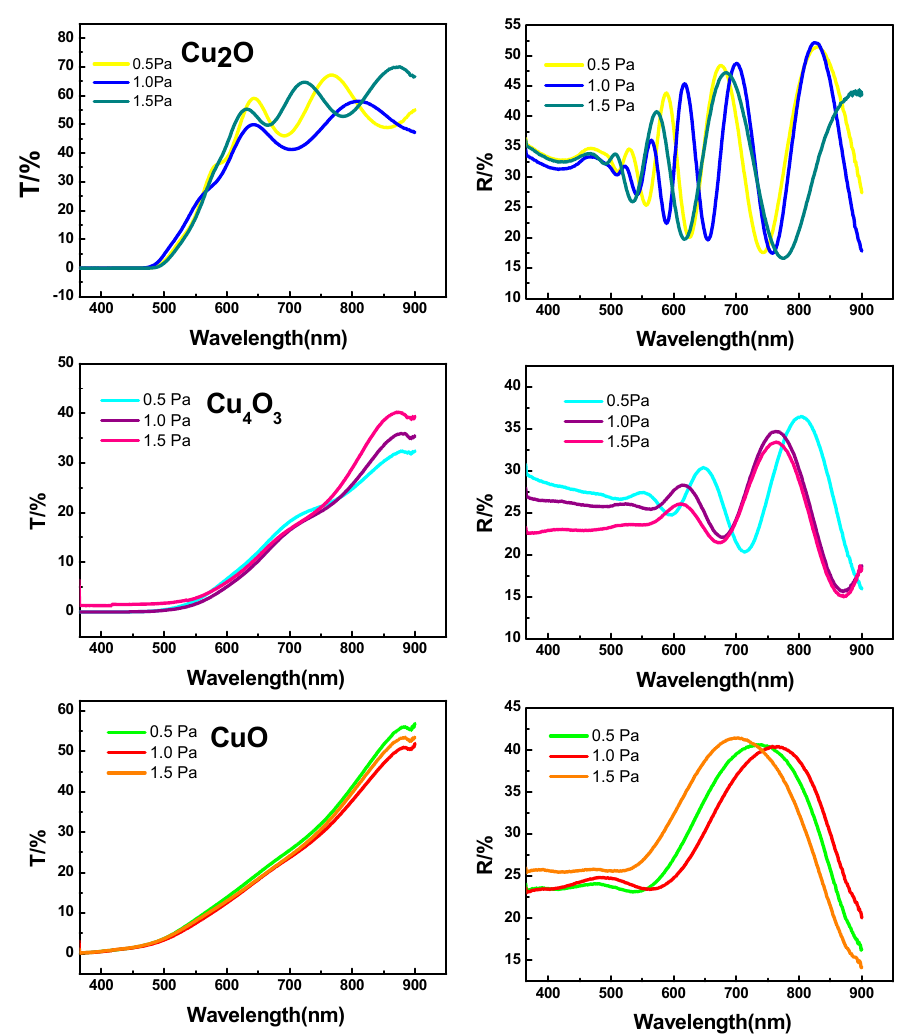
Figure 4. The transmittance and reflectance spectra of Cu 2 O, Cu 4 O 3 , and CuO thin films deposited under various total pressures.